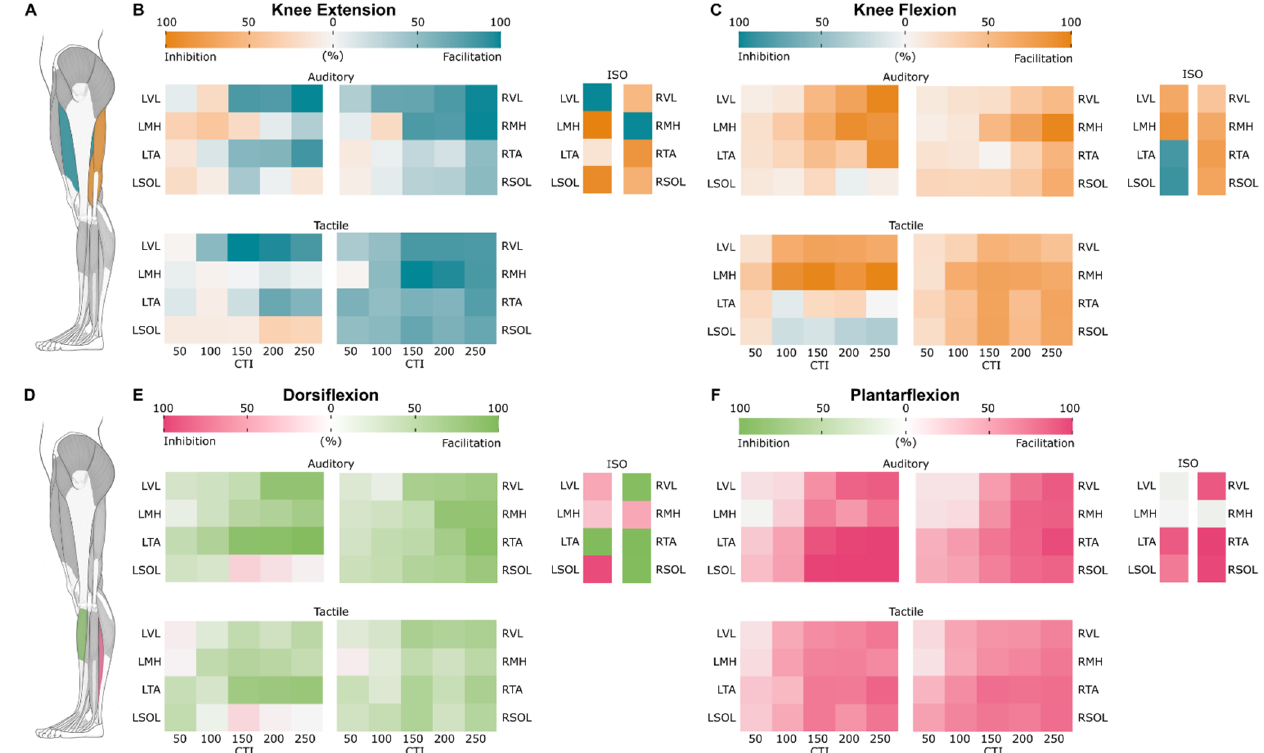
Figure 8. Motoneuronal excitability map: temporal changes in excitability during ( B ) left knee extension (LKE), ( C ) left knee flexion (LKF), ( E ) left dorsiflexion (LDF), and ( F ) left plantarflexion during auditory and tactile conditions, as well as isometric contraction. Each row represents one muscle, and each column represents one CTI. Facilitation and inhibition are denoted using the muscle agonist and antagonist colors, respectively ( A , D ). Note that a high probability of inhibition in antagonists during knee extension and dorsiflexion, as well as a high probability of co-facilitation in antagonists during plantarflexion and knee flexion, occurred across conditions.